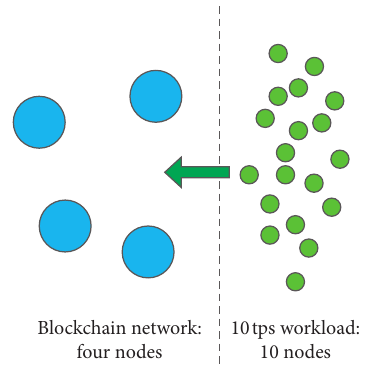
Figure 12: Throughput structure diagram.